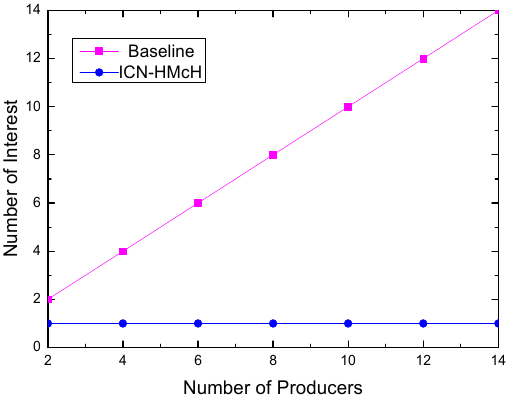
Figure 17. Number of interest.